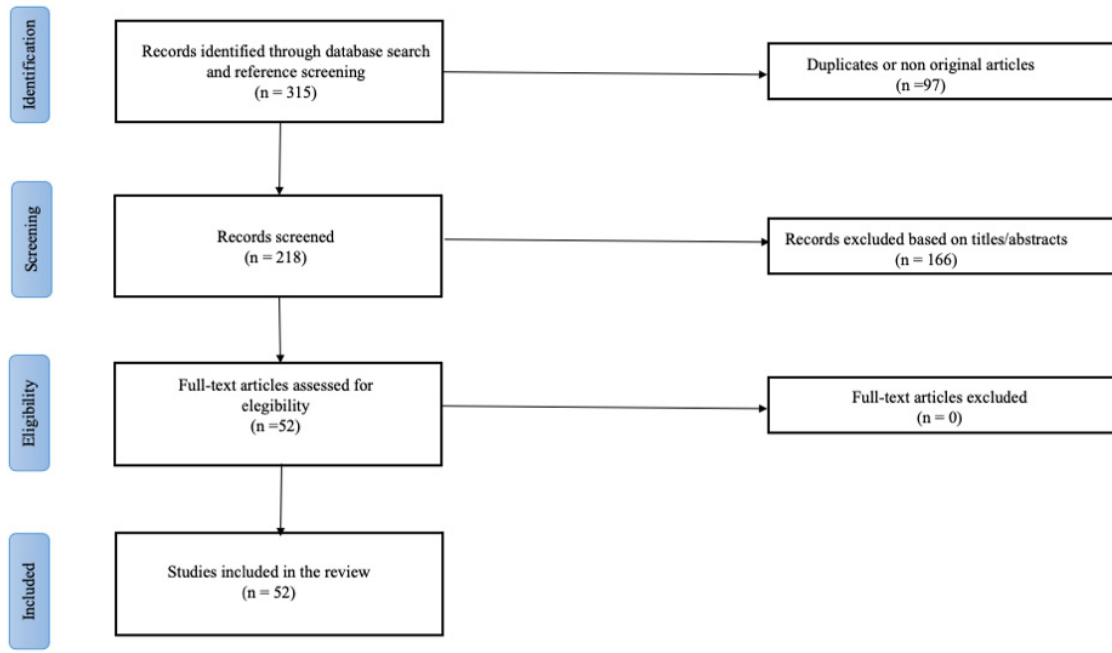
Figure 1. PRISMA-chart summarizing search and selection